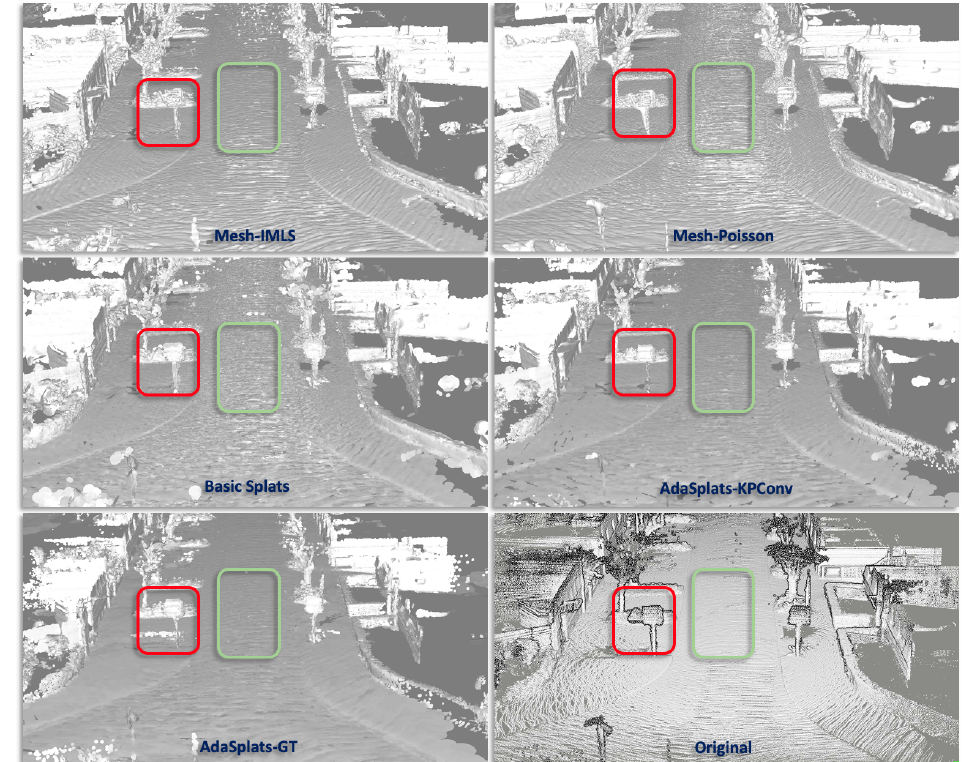
Figure 10. Rendering the different surface representations on SemanticKITTI. The top row shows the meshed scene using IMLS ( left ) and Poisson ( right ). The middle row shows the splatted scene using basic splats ( left ) and AdaSplats using KPConv semantics ( right ). The bottom row shows the splatted scene using AdaSplats-GT, which contains the ground truth point-wise semantic information ( left ) and the original point cloud ( right